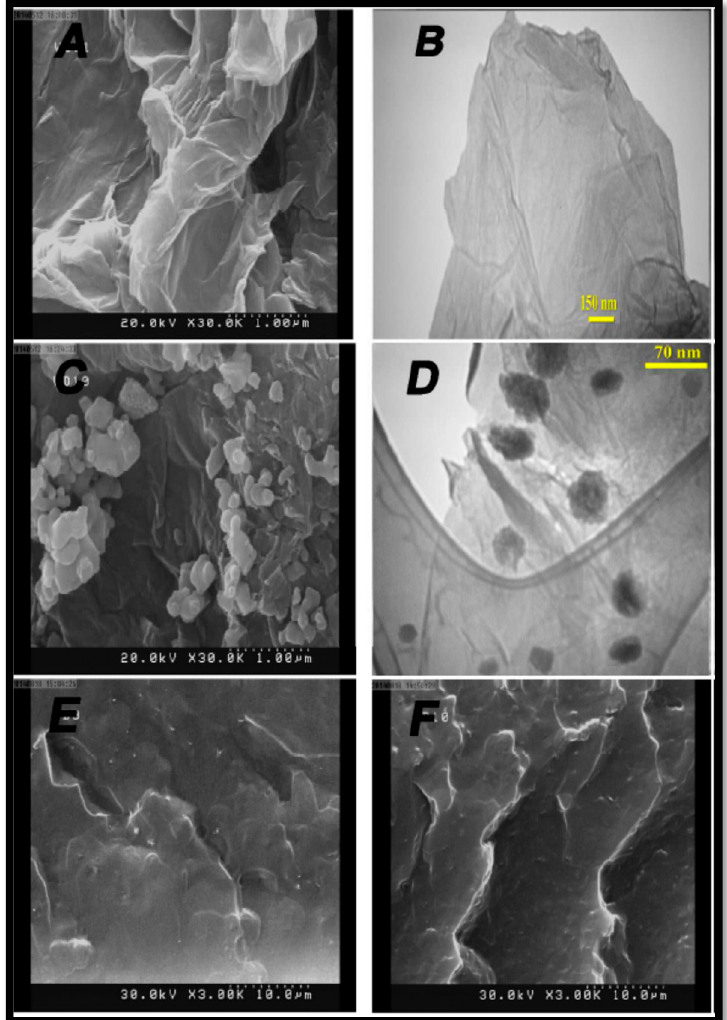
Figure 14. SEM and TEM images of ( A , B ) SGO and ( C , D ) SGO / Fe 3 O 4 nanosheets and cross-sectional SEM images of ( E ) PVA-GLA-SGO-Fe 3 O 4 ( F ) PVA-GLA-SGO membranes. Reproduced from [93], with permission from American Chemical Society, 2015.